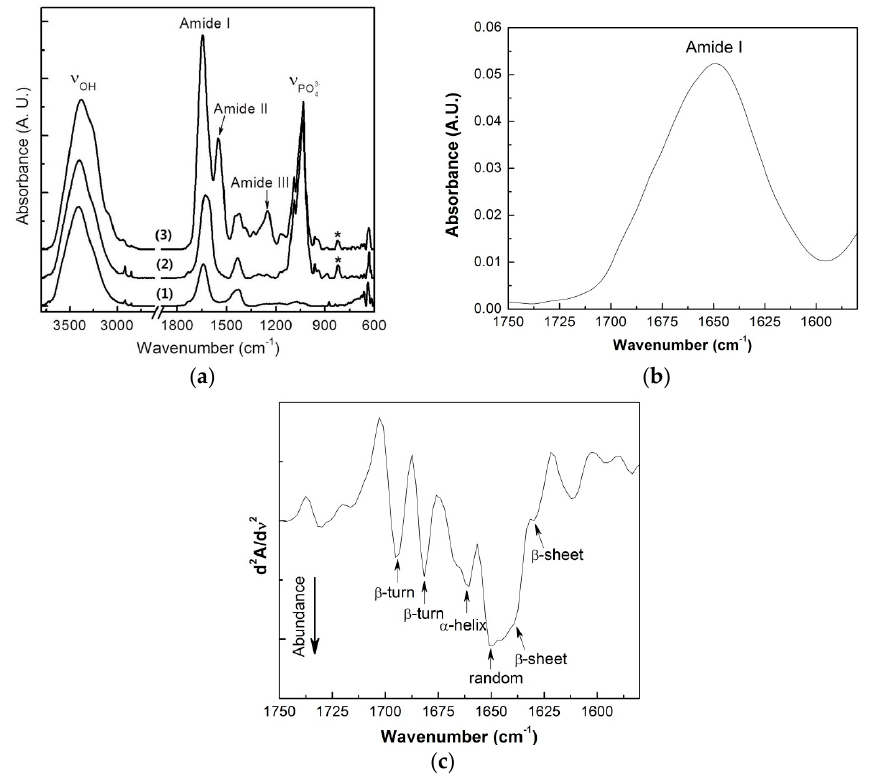
Figure 2. ( a ) Attenuated Total Reflection Fourier Transform Infrared (ATR-FT-IR) absorption spectra of the ( 1 ) Alginate (AL), ( 2 ) AL/Hydroxyapatite (HA), and ( 3 ) AL/HA/Silk fibroin (SF) beads (* indicates the absorption band of HA composition); ( b , c ) the infrared absorption and second derivative spectrum of the amide I of the composited SF.